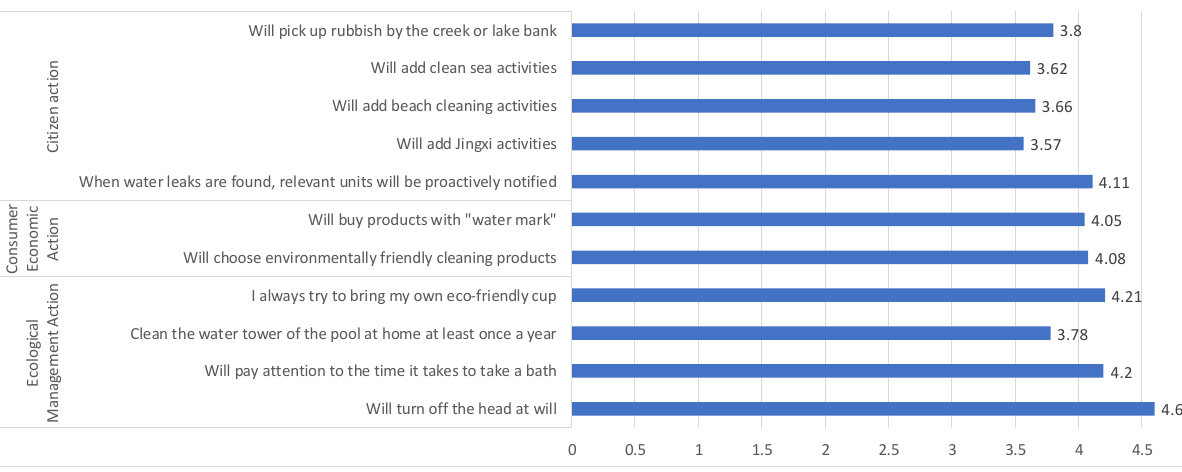
Figure 5. Analysis of water use behavior.